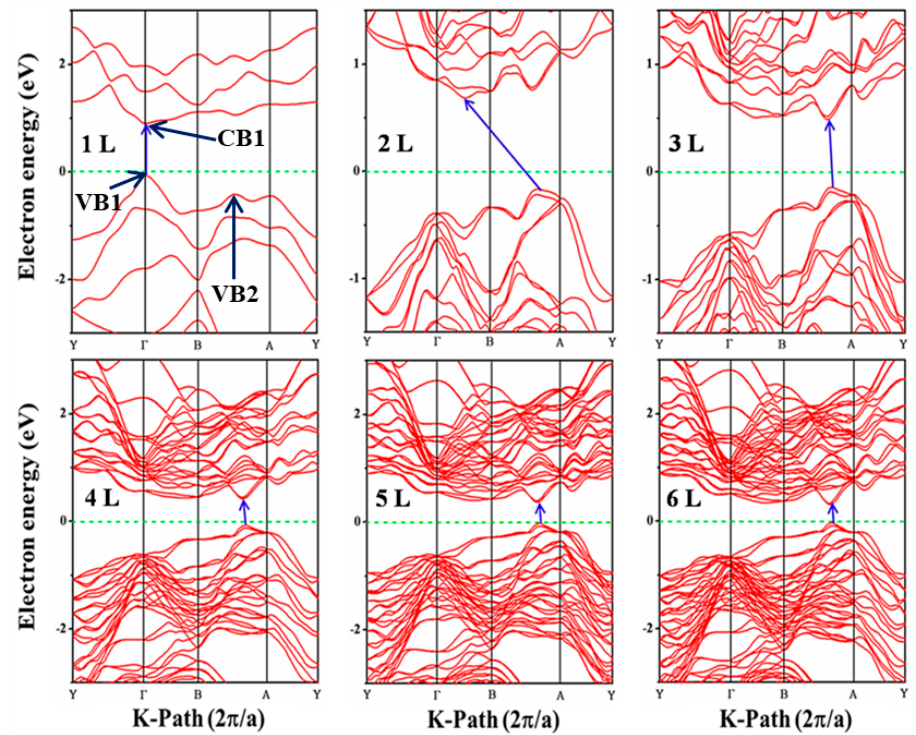
Figure 2. Electronic band structure extracted from PBE with SOC for monolayer (1 L) and few-layer (2 L–6 L) Tellurene.